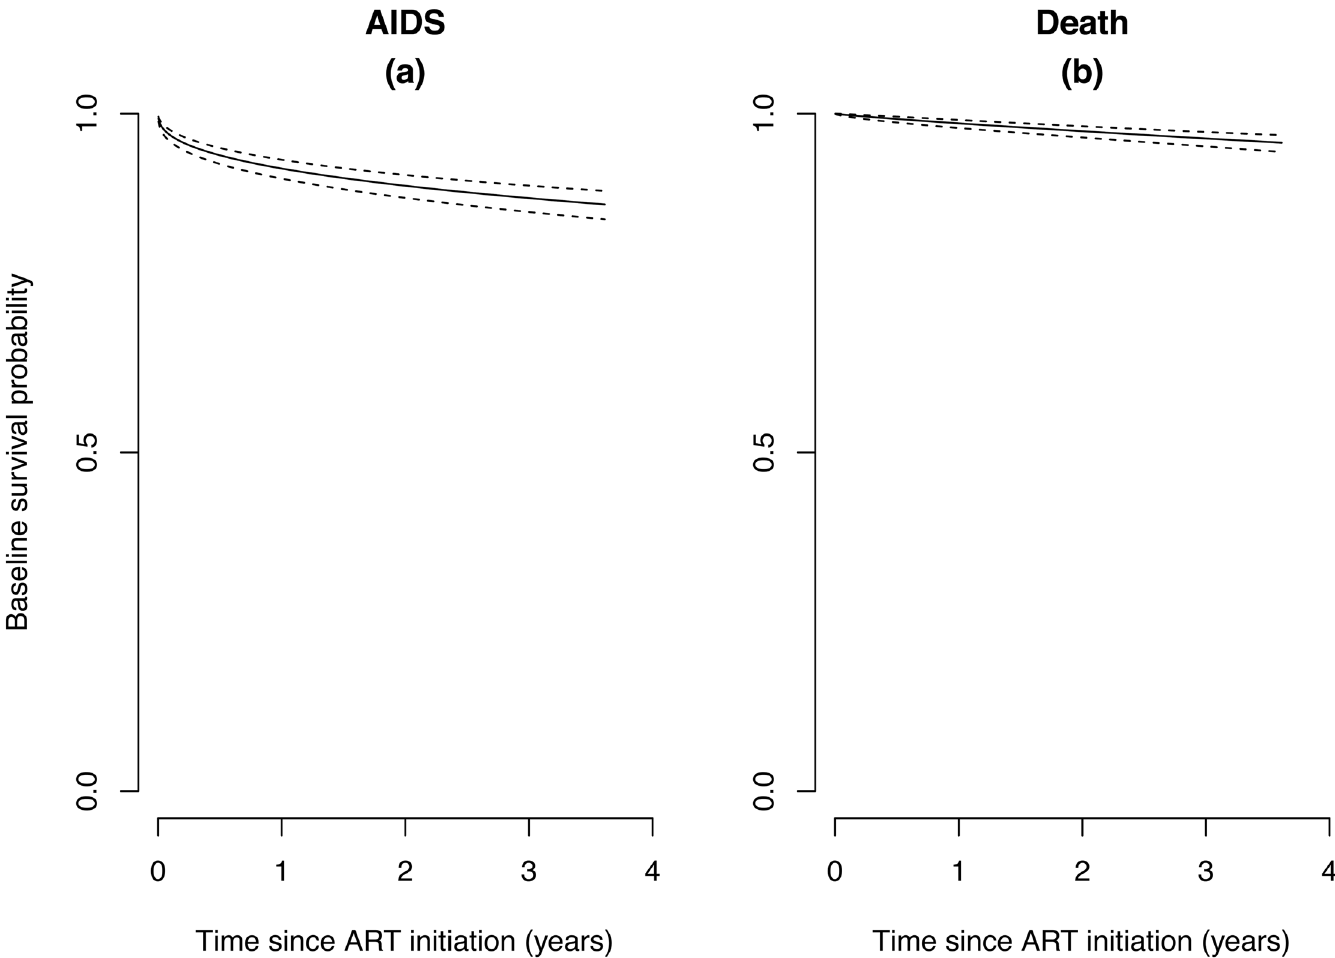
Fig 1. Survival Probabilities on ART in All Study Participants. (a) Survival without new AIDS events on ART. (b) Overall survival on ART. Dotted lines indicate ranges of 95% CIs.